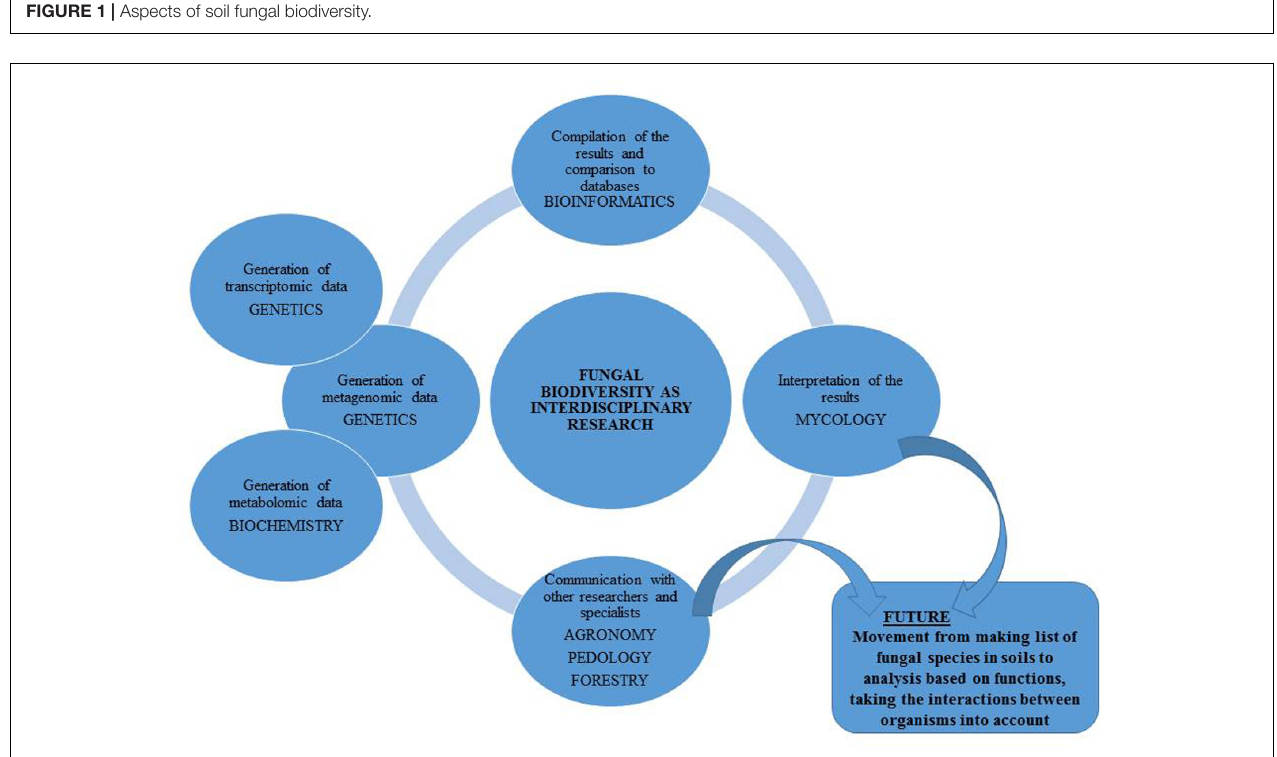
FIGURE 2 | Soil fungal biodiversity as an interdisciplinary